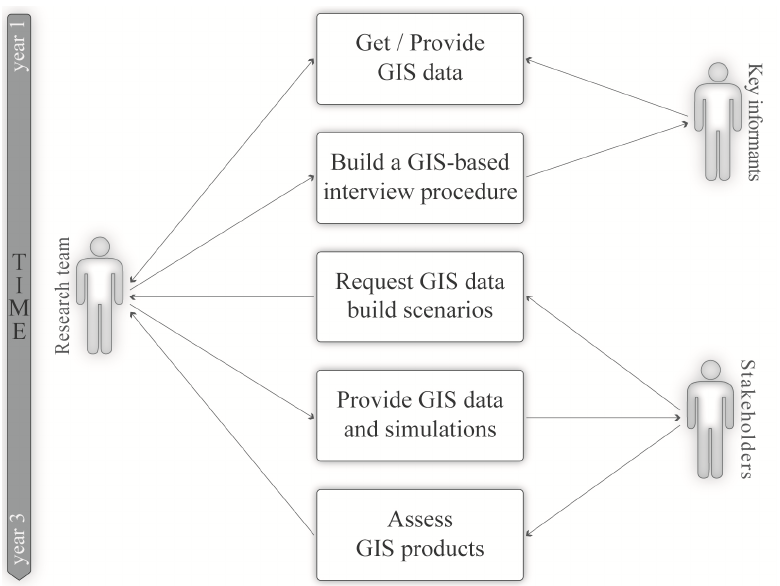
Figure 9. GIS dynamic sharing